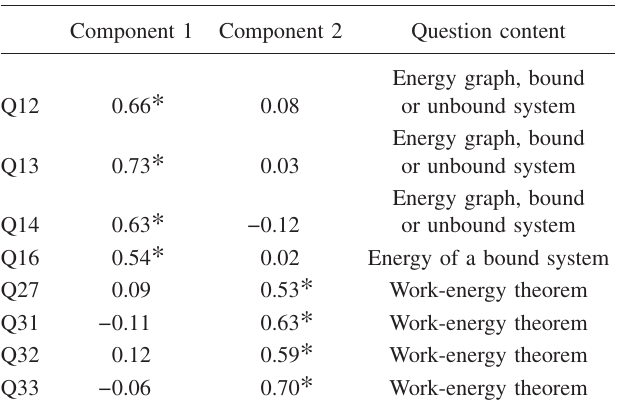
TABLE III. Component loadings for PCA of eight MIET items. An asterisk indicates an “important” factor loading as suggested by Hair et al. (cid:1) Ref. 28 (cid:2) .